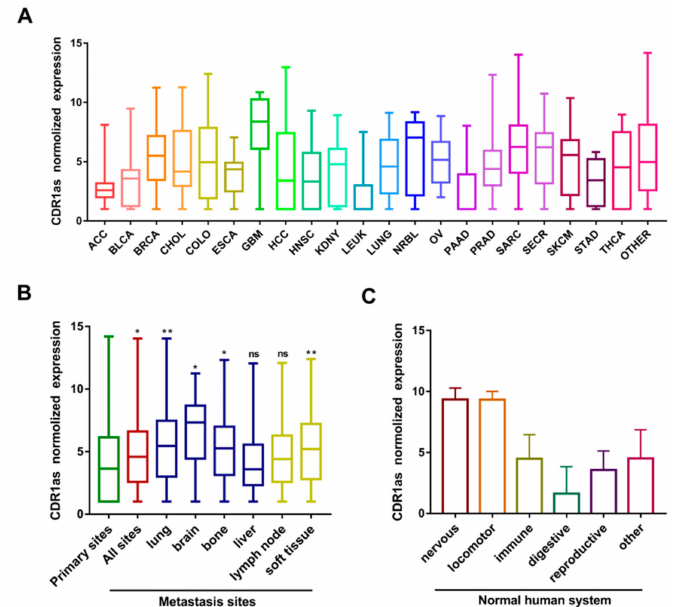
Figure 1. Expression spectrum of CDR1as in di ff erent tissues according to MiOncoCirc database. ( A ) Expression level of CDR1as in di ff erent types of cancer. ( B) Expression level of CDR1as in di ff erent biopsy sites. ( C ) Expression level of CDR1as in di ff erent normal human